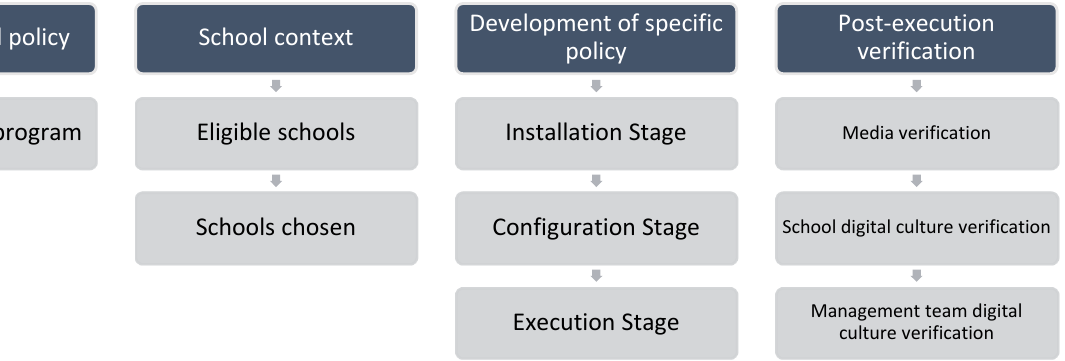
Figure 1. Materials and process.